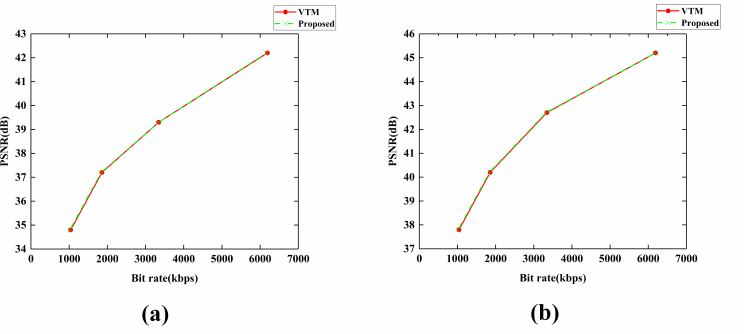
Figure 9. RD performance of the proposed method. ( a ) RD of “PartyScene”. ( b ) RD of “FourPeople”.